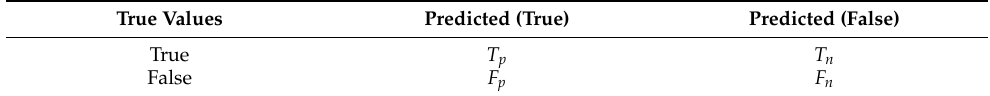
Table 5. Confusion Matrix structure.